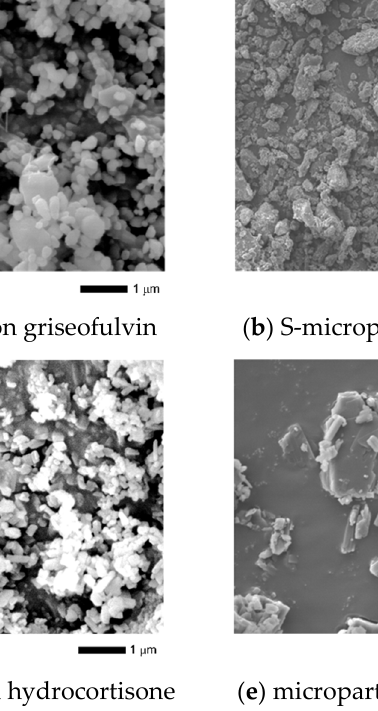
Figure 4. X-ray powder diffraction pattern of: ( a ) griseofulvin samples; ( b ) hydrocortisone samples.